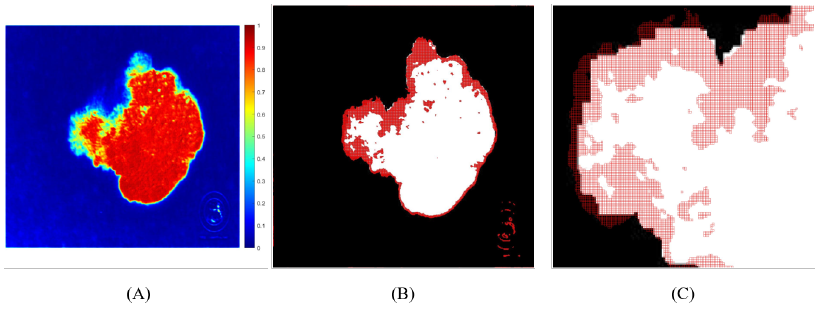
Figure 7. ( A ) Heatmap of confidence entropy values, ( B ) view of pseudo label before replacement with pixels (in red) to be annotated by expert, ( C ) enlarged view of ( B